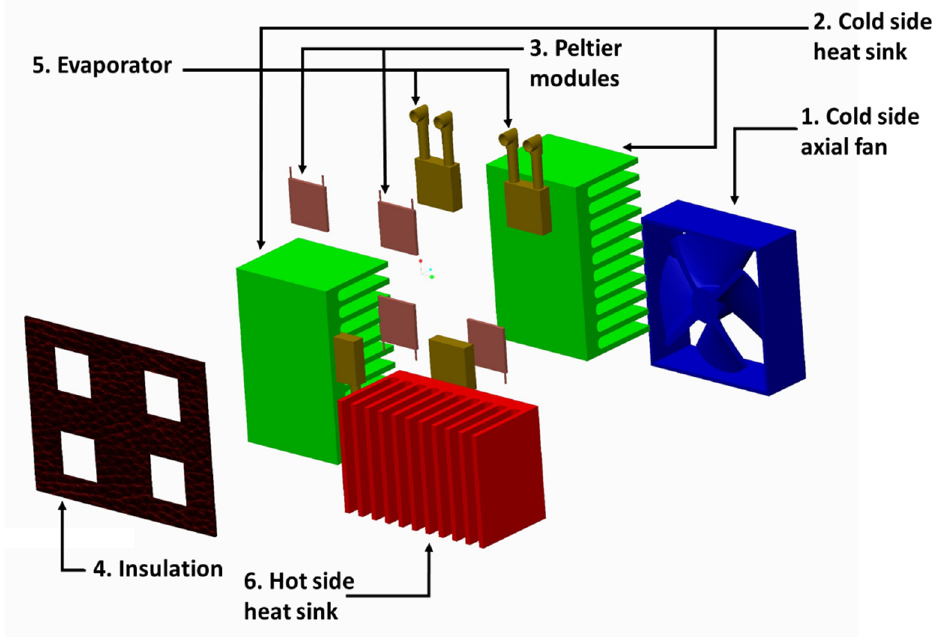
Figure 3. Expanded view of the liquid cooled heat sink assembly. Table 1. Specifications of the liquid-cooled thermoelectric refrigeration system. Sr.